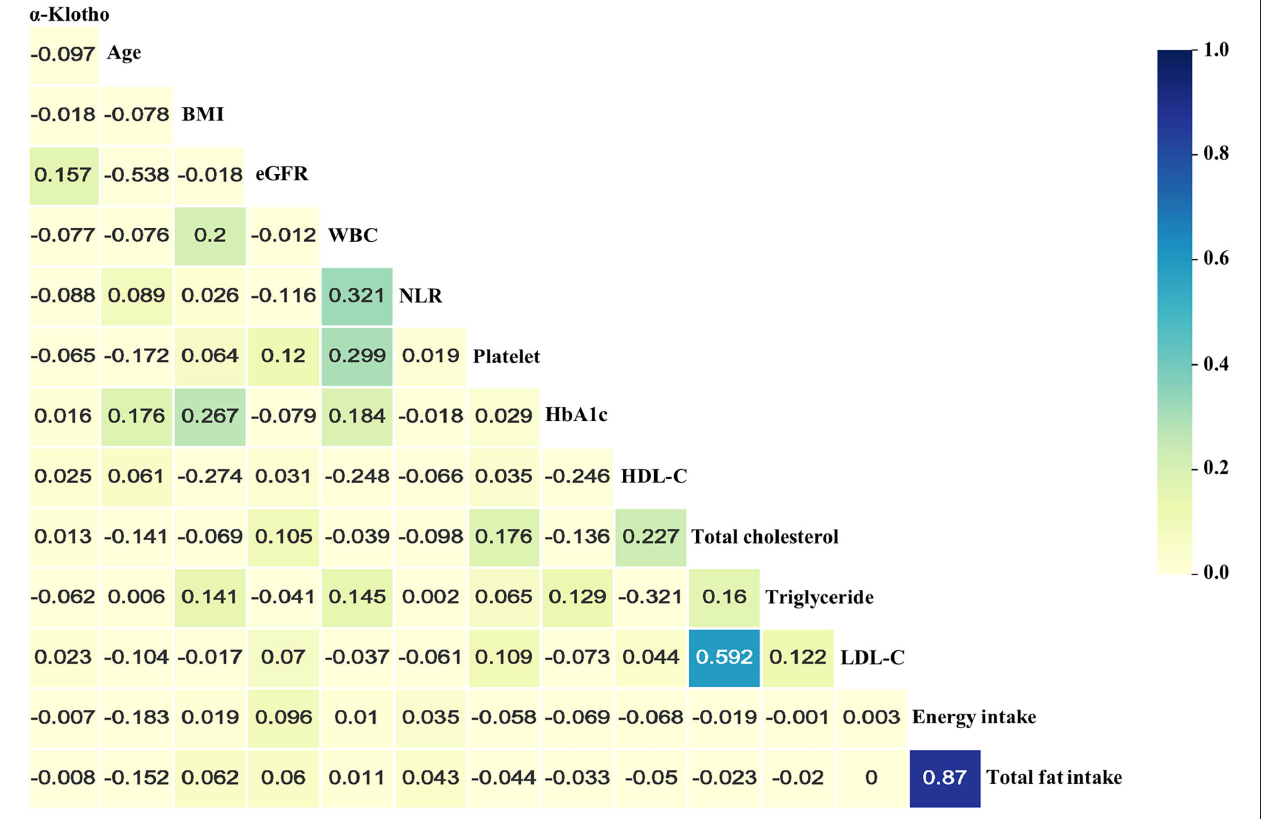
Frontiers in Cardiovascular Medicine |